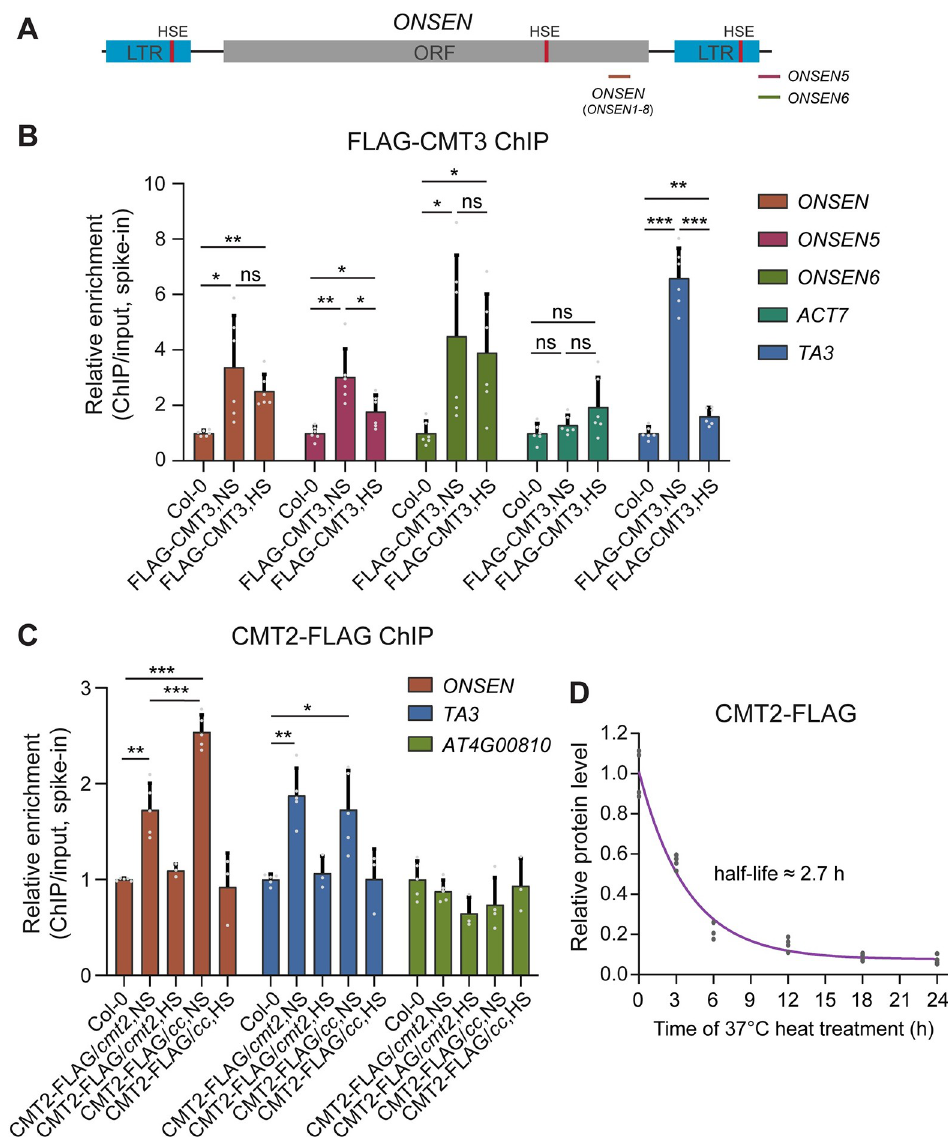
Fig 4. CMT2 binding on ONSEN is increased in cmt3 mutant. (A) A diagram showing ONSEN structure and the locations of ChIP-qPCR amplicons. LTR, long terminal repeat; ORF, open reading frame; HSE, heat-shock element. (B) ChIP-qPCR showing CMT3 enrichment at ONSEN in Col-0 and CMT3 tagged line in cmt3-11 (FLAG-CMT3) under non-stress (NS) or heat stress (HS) conditions. After normalization to input, ChIP samples were further normalized to the respective spike-in of human chromatin. TA3 was used as a positive control, and ACT7 was used as a negative control. All bars represent mean + SD from two biological replicates with all technical replicates shown. Student’s t -test, � P < 0.05; �� P < 0.01; ��� P < 0.001. ns indicates not significant. (C) ChIP-qPCR showing CMT2 enrichment at ONSEN in Col-0 and CMT2 tagged line in cmt2 (CMT2-FLAG/ cmt2 ) and cmt2 cmt3 (CMT2-FLAG/ cc ) under NS or HS conditions. After normalization to input, ChIP samples were further normalized to the respective spike-in of human chromatin. AT4G00810 was used as a negative control. All bars represent mean + SD from two (NS) or one (HS) biological replicates with all technical replicates shown. Student’s t -test, � P < 0.05; �� P < 0.01; ��� P < 0.001. ns indicates not significant. (D) CMT2 protein level in a time-course of heat (37˚C) treatment. The fitting curve was generated using a one-phase decay model, and a half-life was